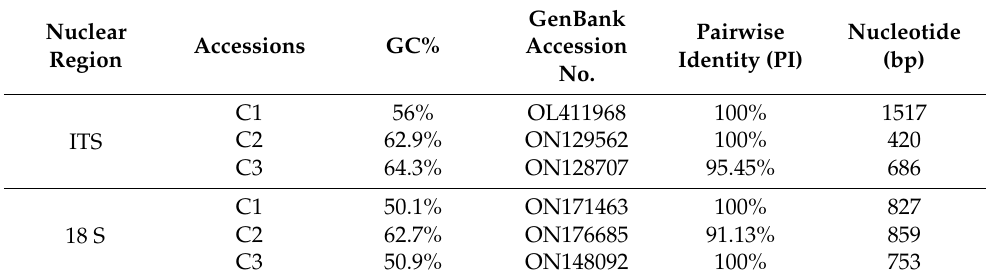
Table 1. Data generated from nuclear DNA region (ITS and 18 S) for the studied C. gileadensis accessions.